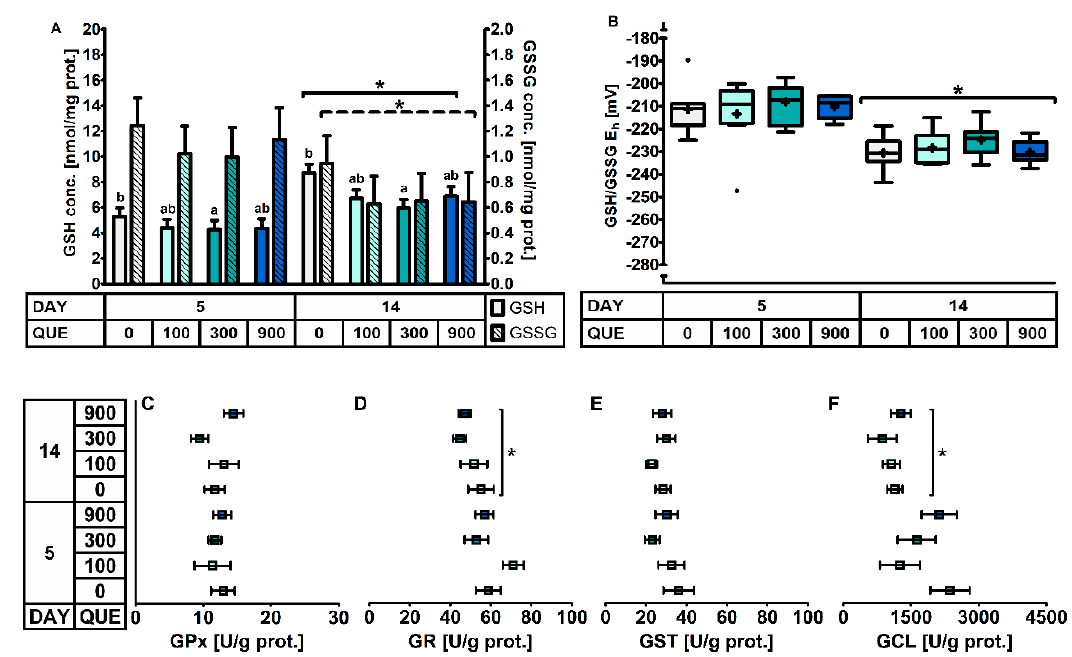
Figure 3. The glutathione redox system in the distal jejunal mucosa of piglets at d5 and d14 post-weaning (DAY), fed a diet containing 0, 100, 300, or 900 mg quercetin/kg diet (QUE) during the first 14d post-weaning. Results are presented as least squares means with SD. Significance levels of main effects and interaction terms are presented in Table 6: ( A ) glutathione (GSH) and glutathione disulphide (GSSG) concentrations; ( B ) Glutathione redox status (GSH/GSSG E h ); ( C ) Glutathione peroxidase (GPx) activity; ( D ) Glutathione reductase (GR) activity; ( E ) Glutathione transferase (GST) activity; ( F ) Glutamate-cysteine ligase (GCL) activity. * Represents the effect of DAY across other factors ( p ≤ 0.05).